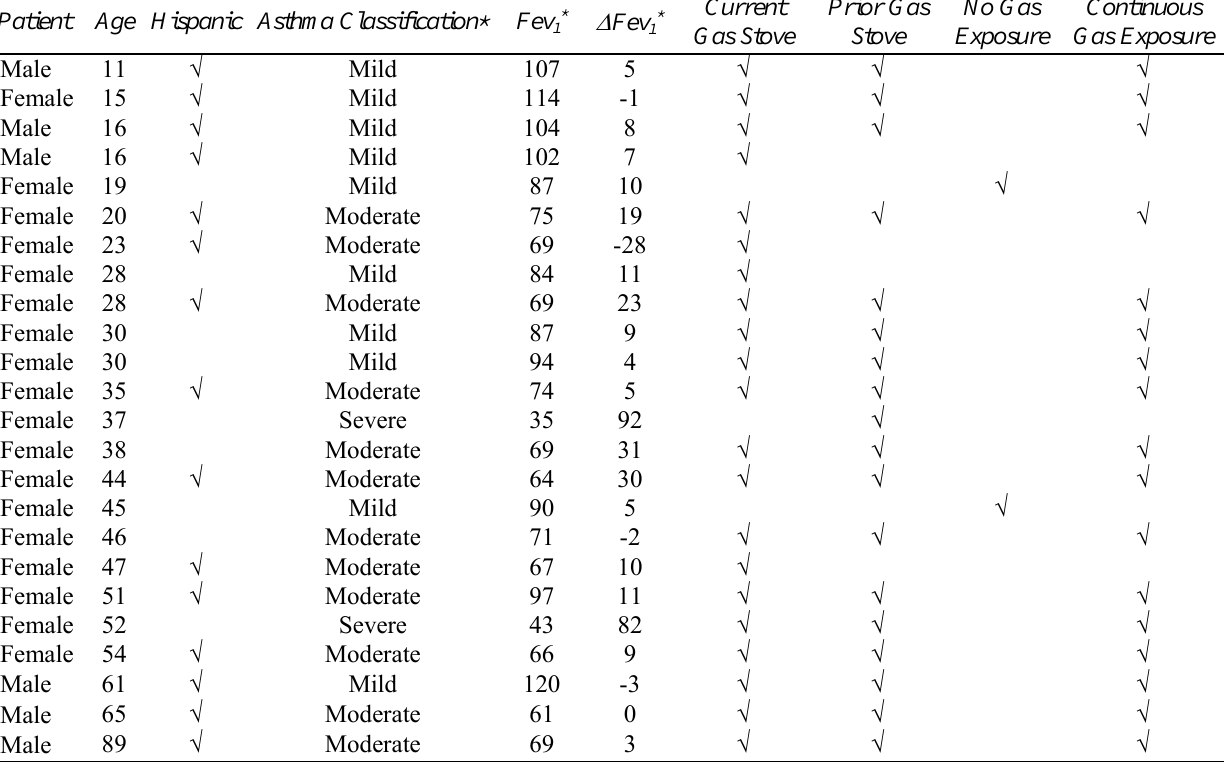
Table 1: Clinical Response – Asthma Incidence Vs. Gas Stove (Kitchen) Exposures (2003/2004)